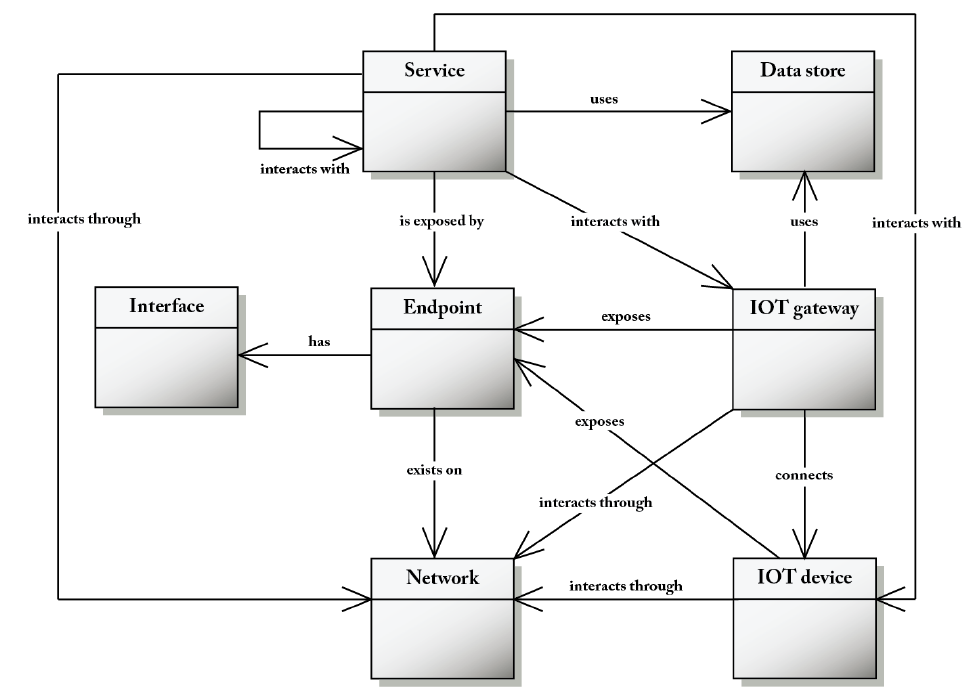
Figure 4. The service, network, IoT device and IoT gateway concepts of the